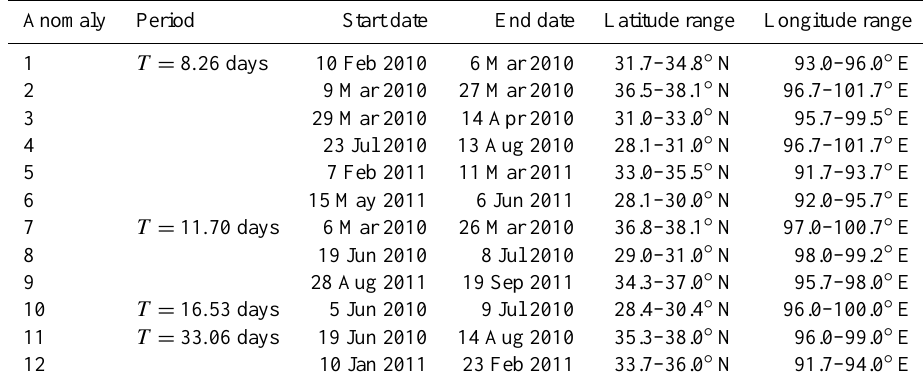
Table 1. RWPS anomalies in the six frequency bands in the selected area during analysis period. Anomaly Period Start date Latitude range